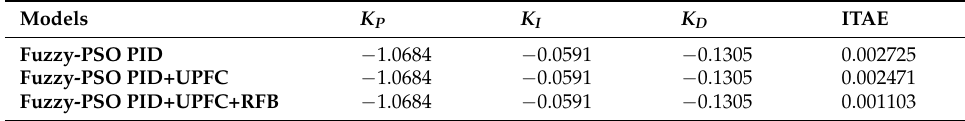
Table 3. Numerical outcomes of Fuzzy-PSO